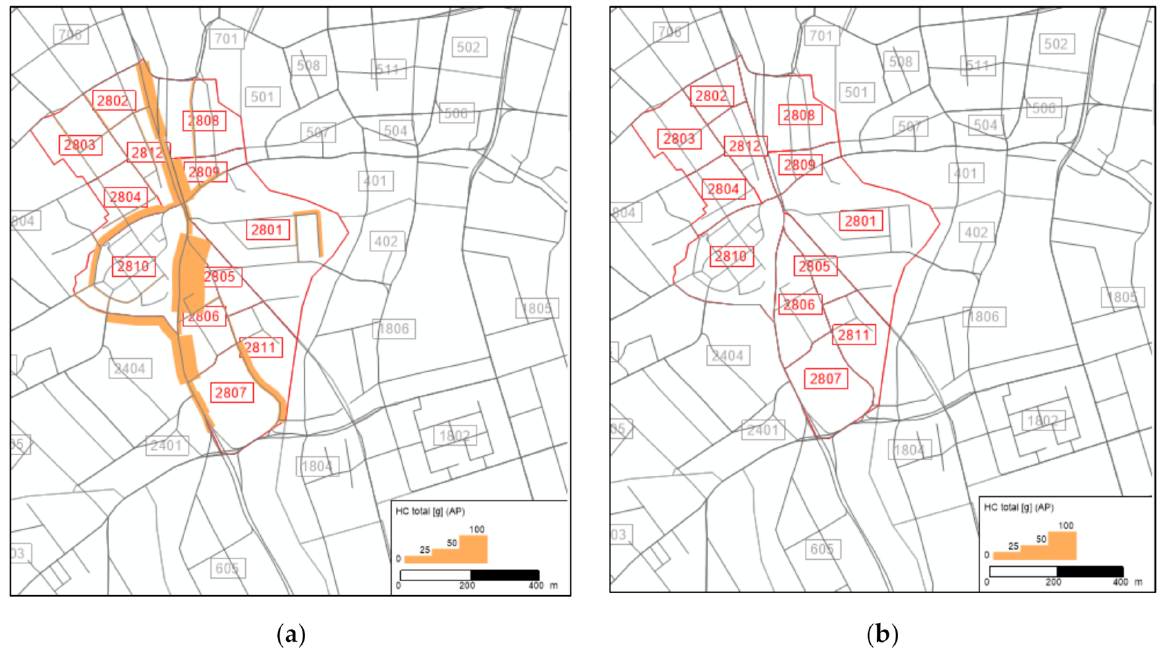
Figure 15. The assessment of HC total [g] (measure from Group 1) for scenario W0 and optimal scenario (W3)—analysis for the central areas of the city: ( a ) measures for scenario W0; ( b ) measures for scenario